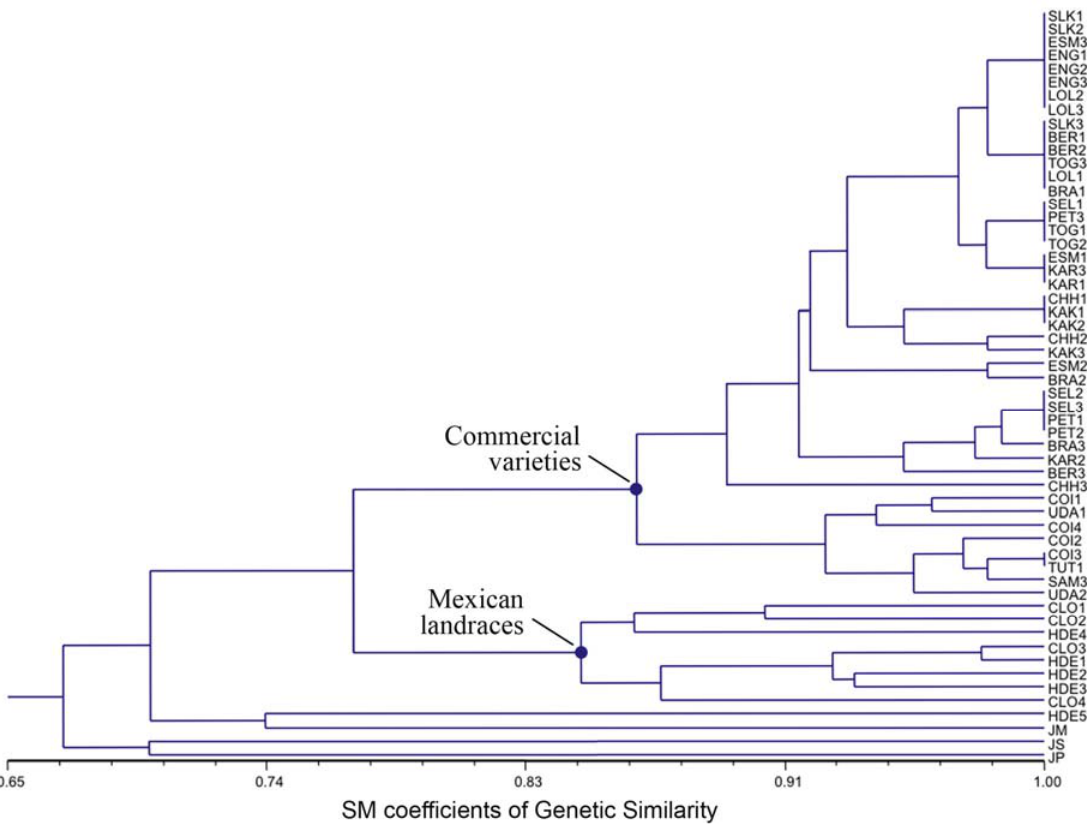
Figure 3. Dendrogram of J. curcas accessions based on SSR marker data using the Simple Matching genetic similarity matrix and the UPGMA clustering method. The two main nodes refer to the subgroups of commercial varieties and Mexican